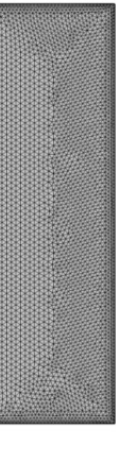
Figure 3. Two-dimensional (2D) mesh generation of the batch reactor.